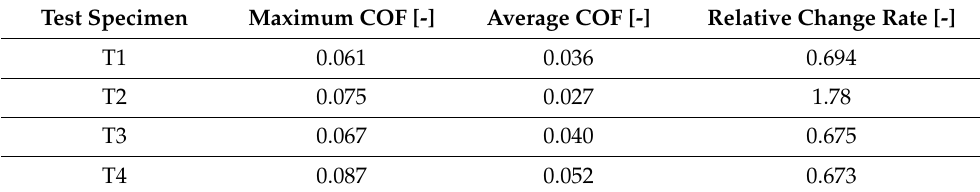
Table 7. Friction coefficient value of friction specimens.